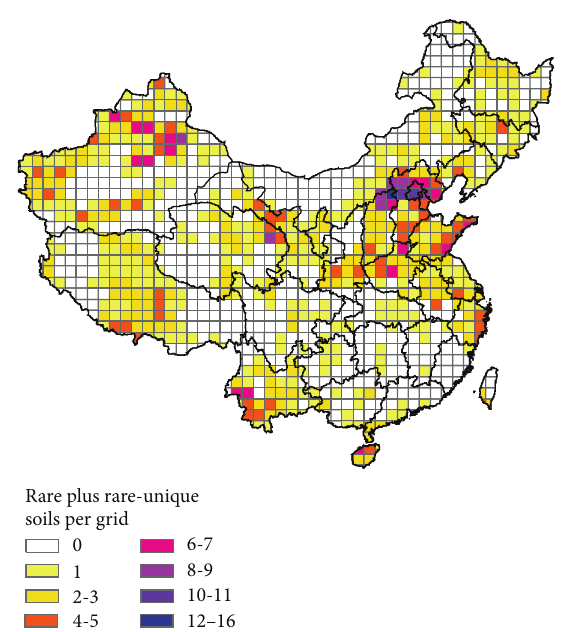
Figure 5: Rare plus rare-unique soils per grid in China (the taxonomic level of the soil map is shown in Figure